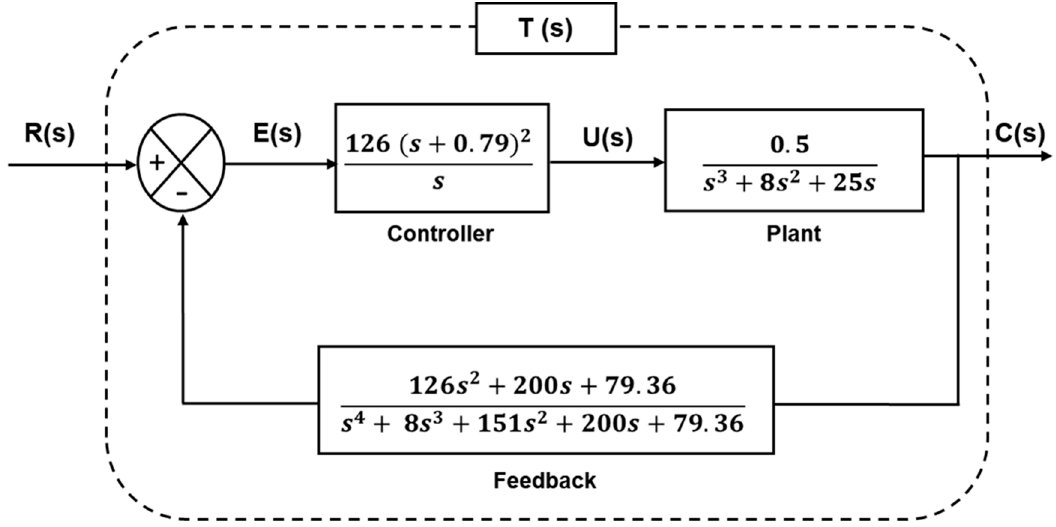
Figure 4. PID control algorithm for position control.